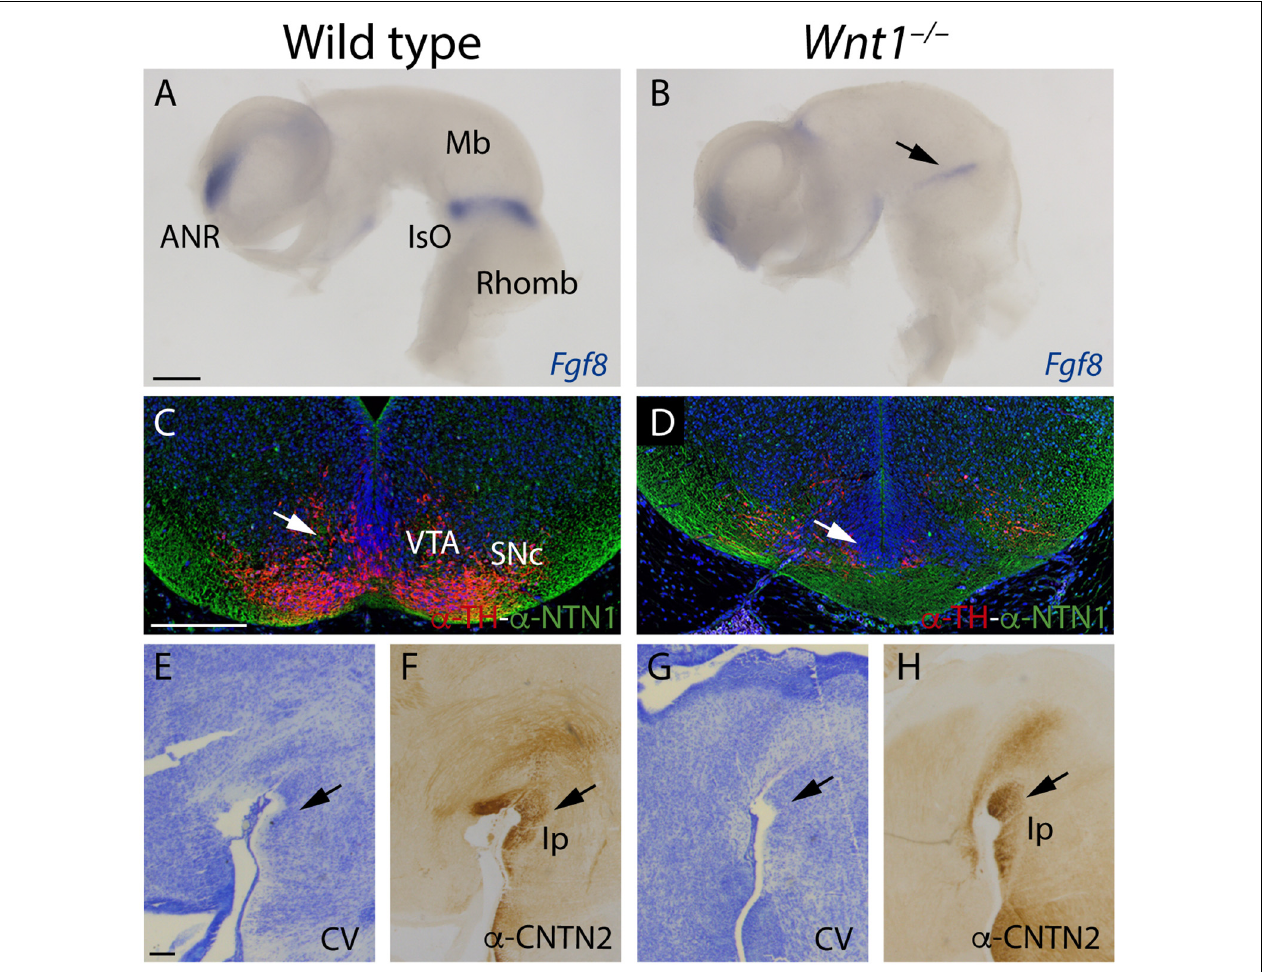
FIGURE 7 | Study of the altered territories in the Wnt1 − / − fr pathway. (A,B) Fgf8 in situ hybridization. Arrow in (B) shows a reduction of Fgf8 expression in the mutant. (C,D) Immunofluorescence against TH and NTN1 in coronal sections of E15.5 brains. Arrows in (C,D) indicates the alterations observed in the mutant (NTN1 and TH + cells reduction). (E–H) Sagittal sections of E15.5 brains, (E,G) Cresyl Violet staining, and (F,H) immunohistochemistry against CNTN2 (arrows in F,H indicate the interpeduncular nucleus). Three samples of each genotype have been analyzed. ANR, anterior neural ridge; Mb, midbrain; IsO, isthmic organizer; Rhomb, rhombencephalon; VTA, ventral tegmental area; SNc, substantia nigra pars compacta; Ip, interpeduncular nucleus; CV, Cresyl Violet. Scale bar: 200 µ